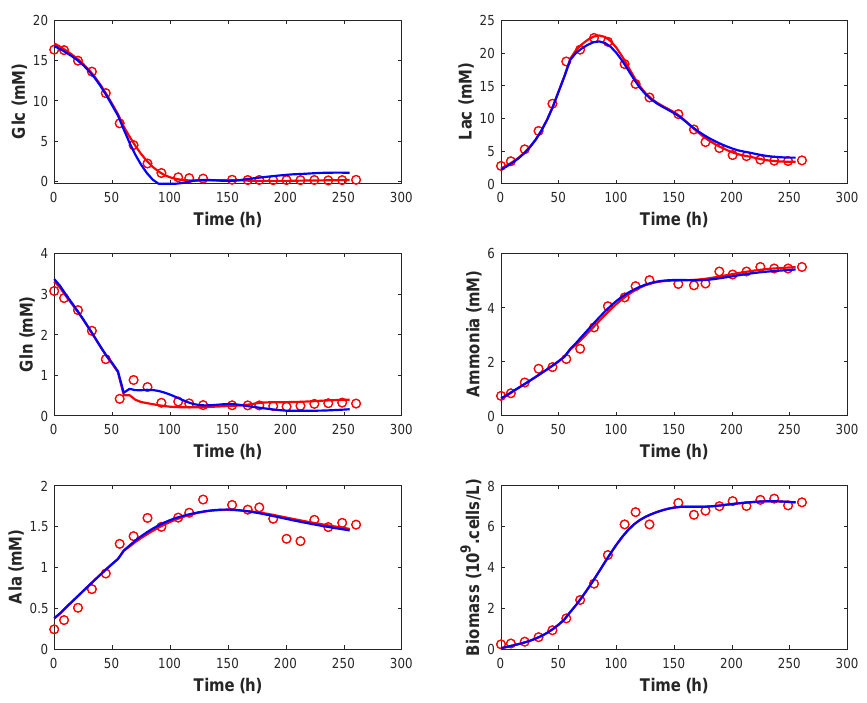
Figure 8. Time evolution of the measured concentrations in dataset # 2—experimental data points (red bullets); concentration profiles on the basis of n EFM = Ω = 10 (red curves) and selecting n EFM = Λ = 5 (blue